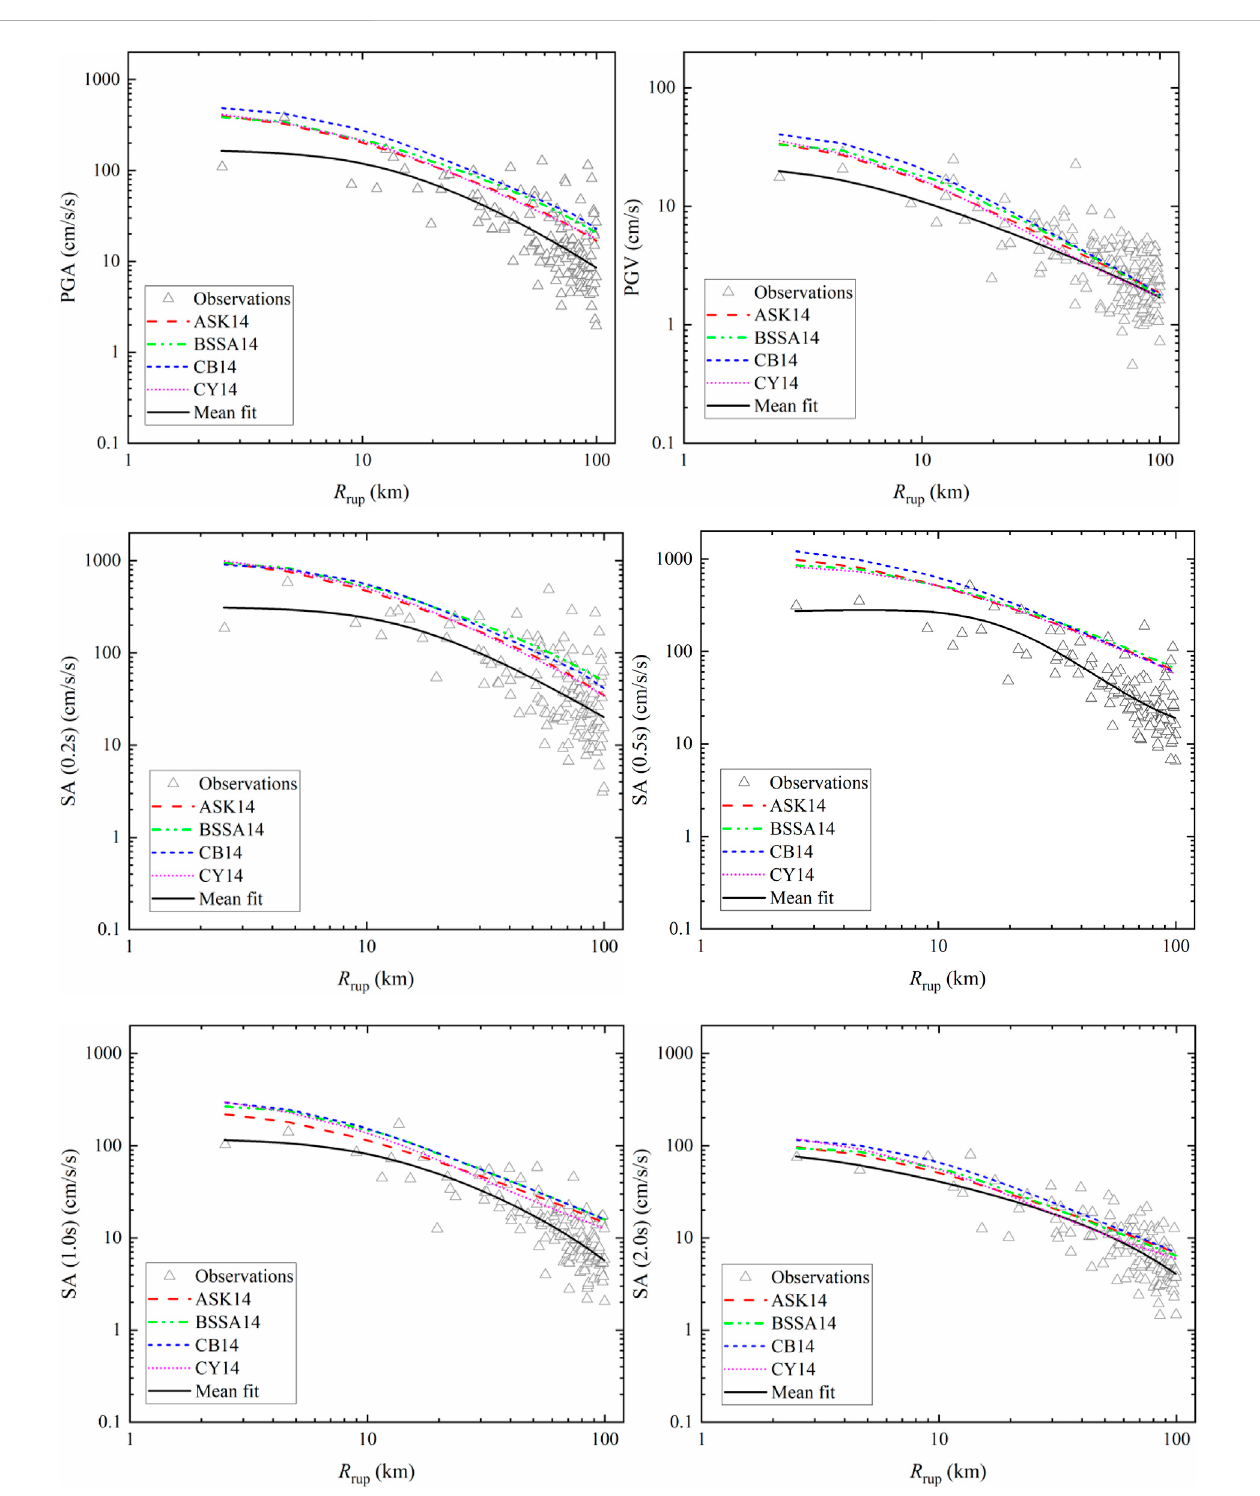
FIGURE 6 Variations in observed horizontal ground motion with R rup and comparison with NGA-West2 models ASK14, BSSA14, CB14, and CY14, which are the predictions of Abrahamson et al. (2014), Boore et al. (2014), Campbell and Bozorgnia (2014), and Chiou and Youngs (2014), respectively. The mean fi t curve denotes the regression results of the observed ground motion of this event. All of the observation data have been adjusted to the site condition of V S30 = 760 m/s based on the Seyhan and Stewart (2014) model (SS14). We used V S30 = 760 m/s for all of the NGA-West2